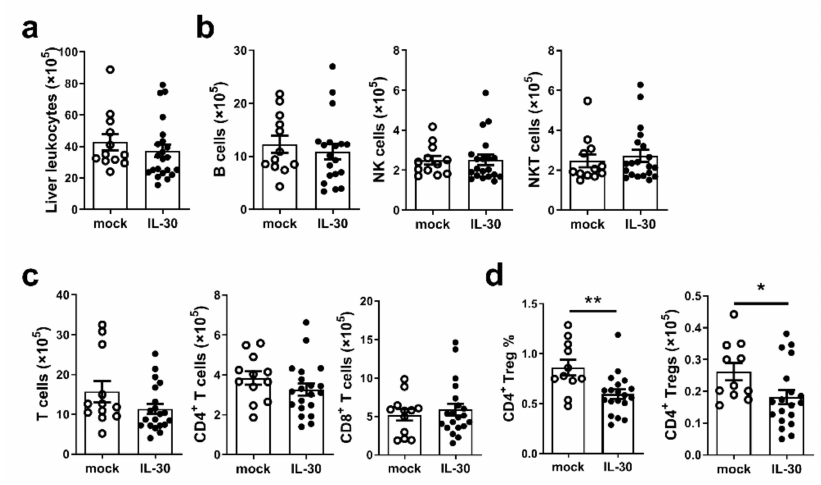
Figure 3. Administration of AAV-mIL-30 decreased the numbers of Foxp3-Tregs in 2-OA-OVA- induced autoimmune cholangitis mice. Foxp3 GFP mice were injected with AAV-mIL-30 or AAV-mock at 3 weeks after the first 2-OA-OVA immunization and sacrificed at Week 5. ( a ) The numbers of leukocytes in the liver were measured. ( b ) The numbers of B, NK, and NKT cells in the liver were measured. ( c ) The numbers of CD4 + and CD8 + T cells in the liver were measured. ( d ) The percentages and numbers of CD4 + Foxp3-Tregs in the liver were measured. Each dot represents an individual mouse. n = 12–20 mice per group. All error bars denote ± SEM. *, p < 0.05; **, p <